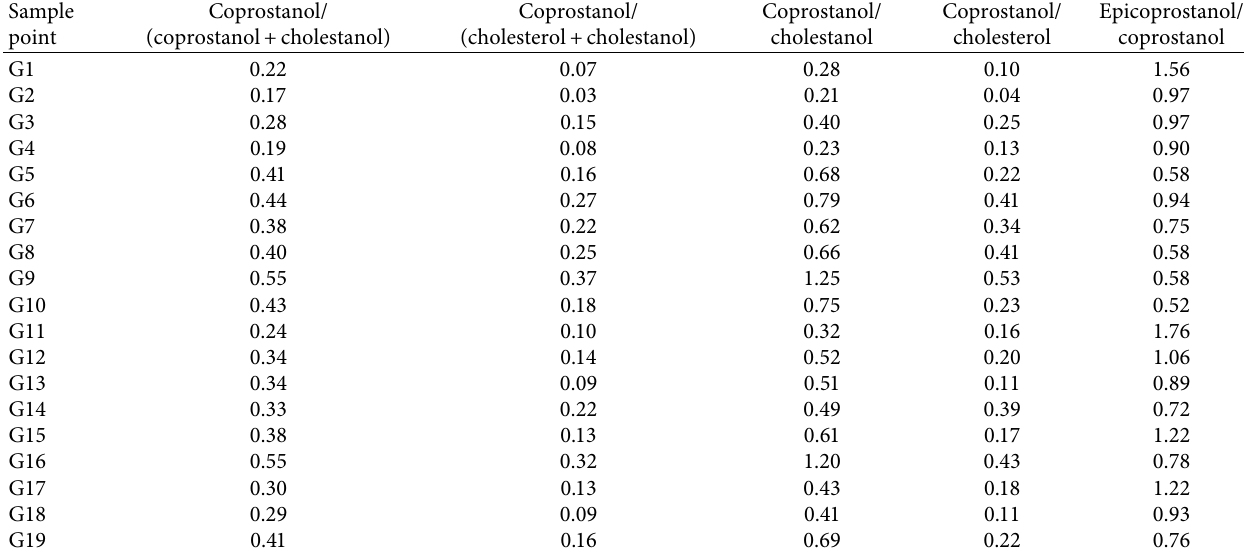
Table 5: Sterol ratio parameters in the Guanting Reservoir